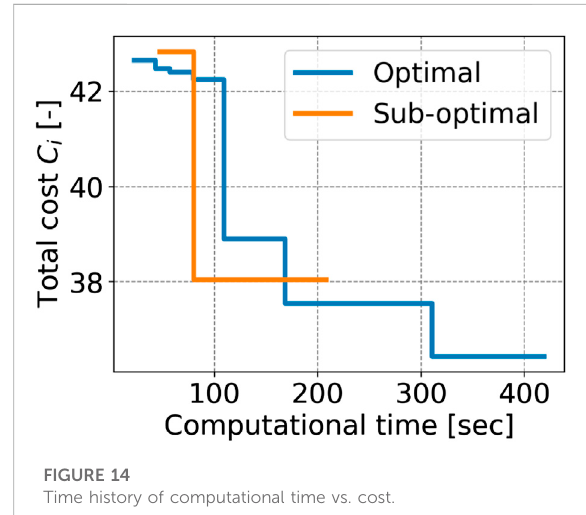
FIGURE 12 GPR model for the TQGR-based analysis module, which shows the terrain roughness vs. the planning stop criterion.